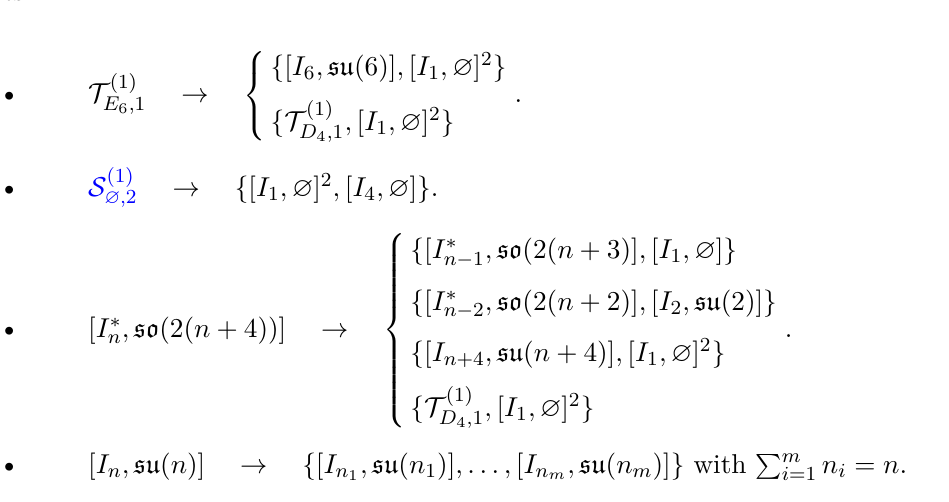
Figure 4 . Coulomb branch analysis of the mass deformations among the entries of the e 8 − so (20)